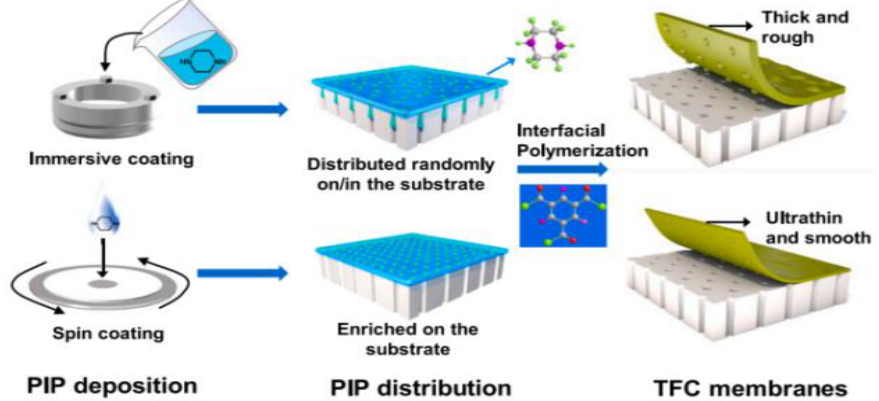
Figure 4. Schematically illustrated synthesizing PA membranes using IP and SCIP methods [108]. Ren et al. [109] designed a durable protein-resistant multilayer system using poly(sulfobetaine methacrylate) (PSBMA) and tannic acid (TA) through an LBL assembly approach to improving hydrophilicity and resistance to proteins. Increasing the number of bilayers in the (TA/PSBMA)n multilayers resulted in a change in surface hydrophilicity, and (TA/PSBMA)20 multilayers demonstrated superior hydrophilicity and antifouling properties than others with fewer bilayer numbers ( n = 5, 10,